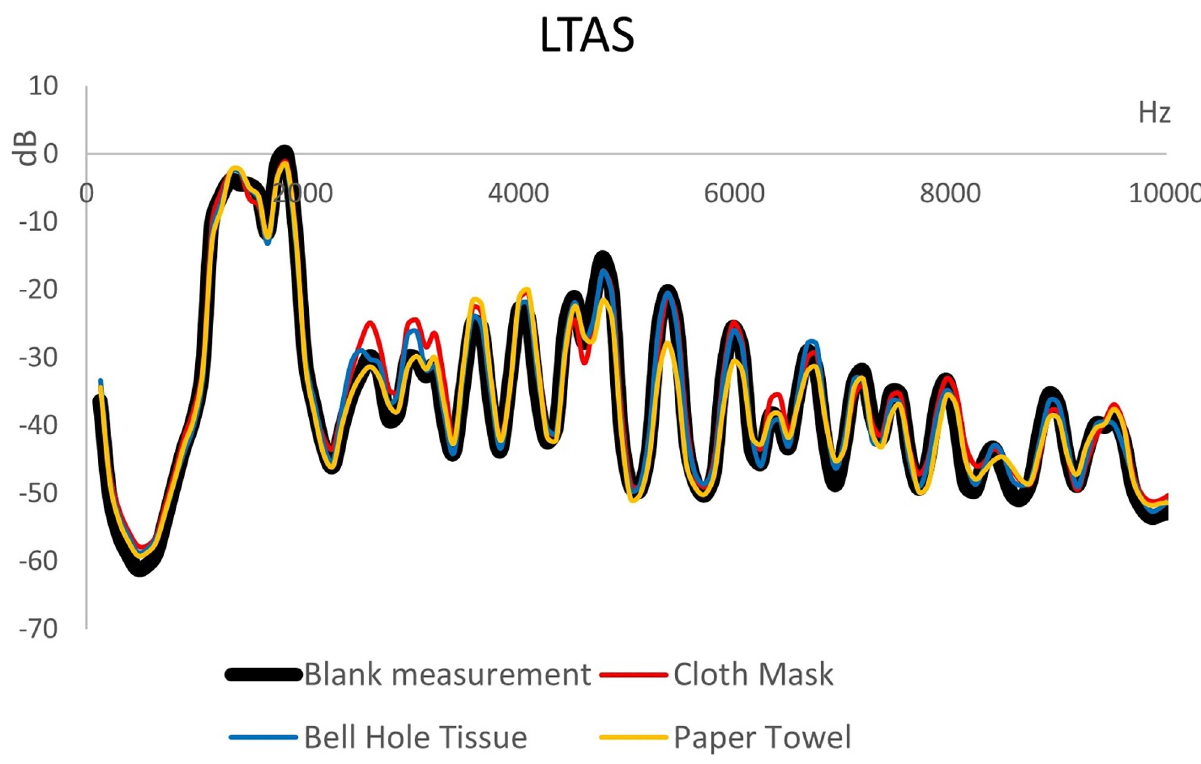
Fig 5. Long-term average spectra (LTAS) when playing the same melody with and without potential safety devices. The presented curves are the averages of all players sorted by task.